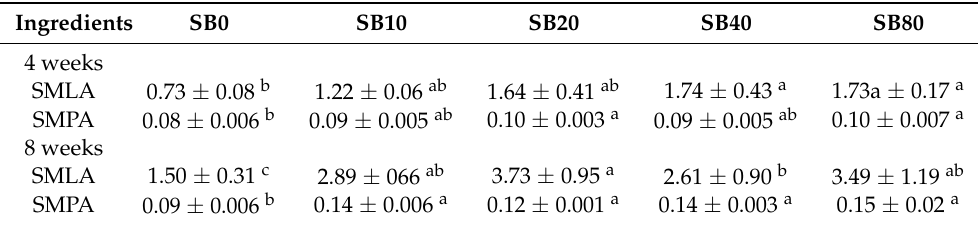
Table 4. Skin mucus lysozyme and peroxidase activities of O. niloticus after 4 and 8 weeks feeding with experimental diets: SB0 (0 -control), SB10 (10 g kg − 1 ), SB20 (20 g kg − 1 ), SB40 (40 g kg − 1 ), and SB80 (80 g kg − 1 ).